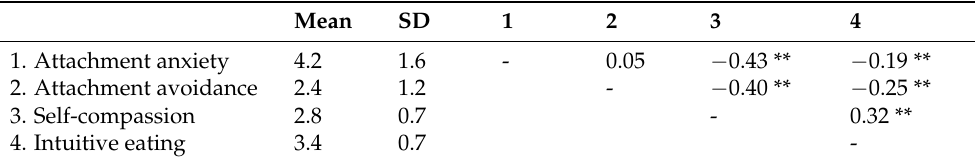
Table 2. Descriptive statistics and bivariate Pearson correlations among variables in the model.